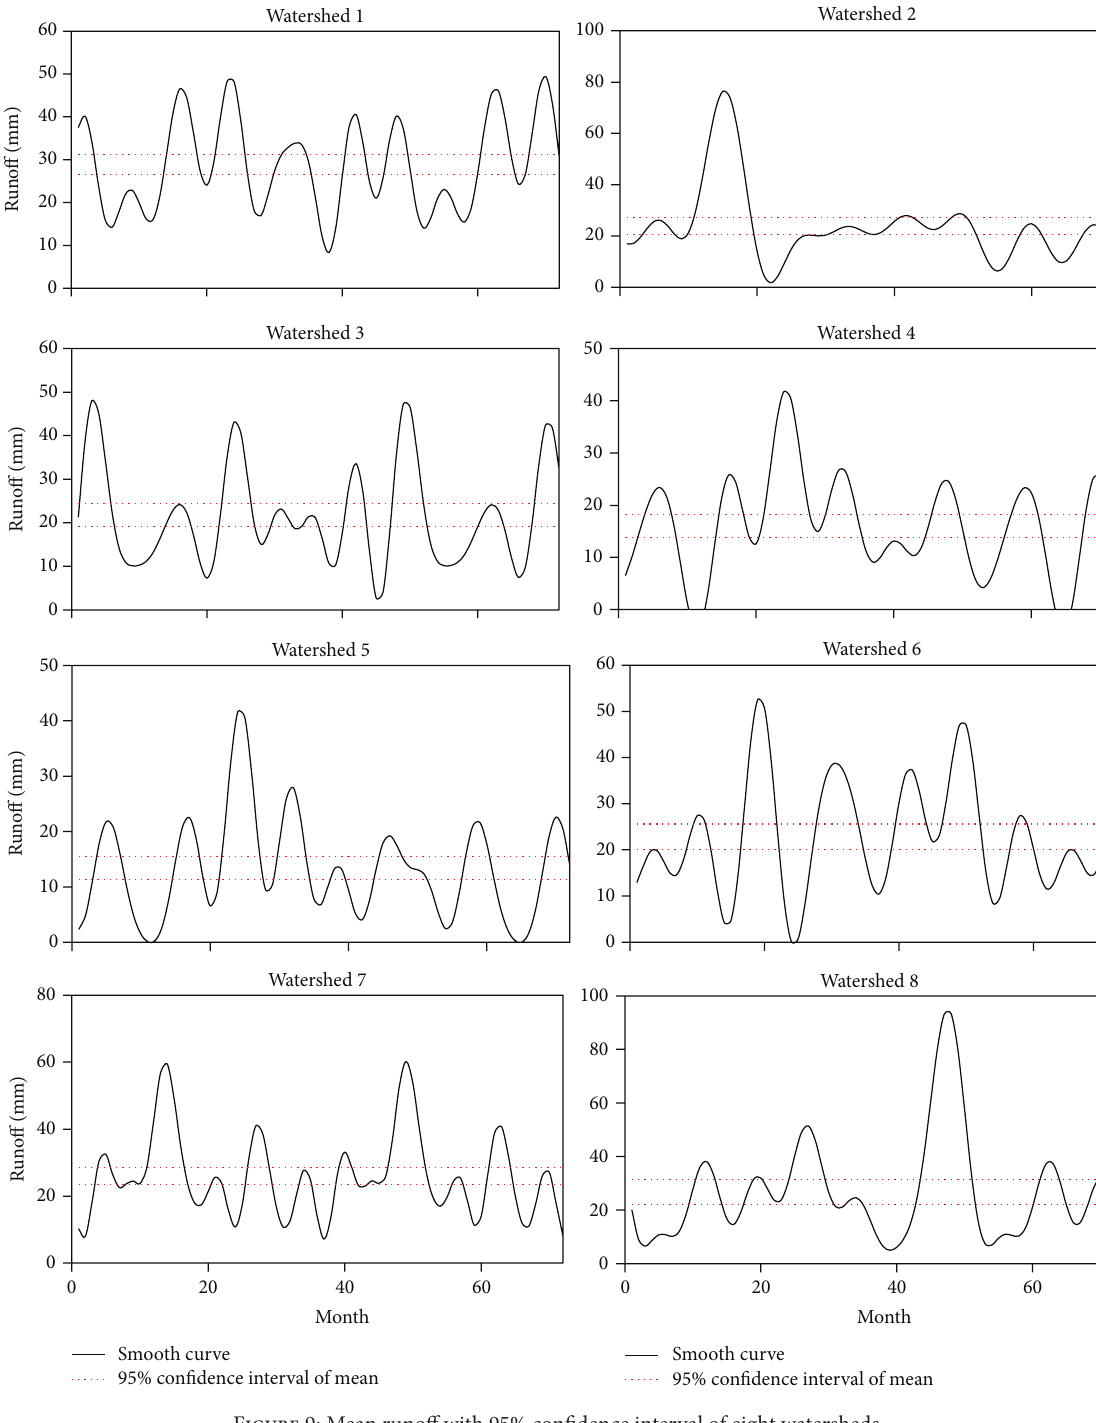
Figure 9: Mean runoff with 95% confidence interval of eight